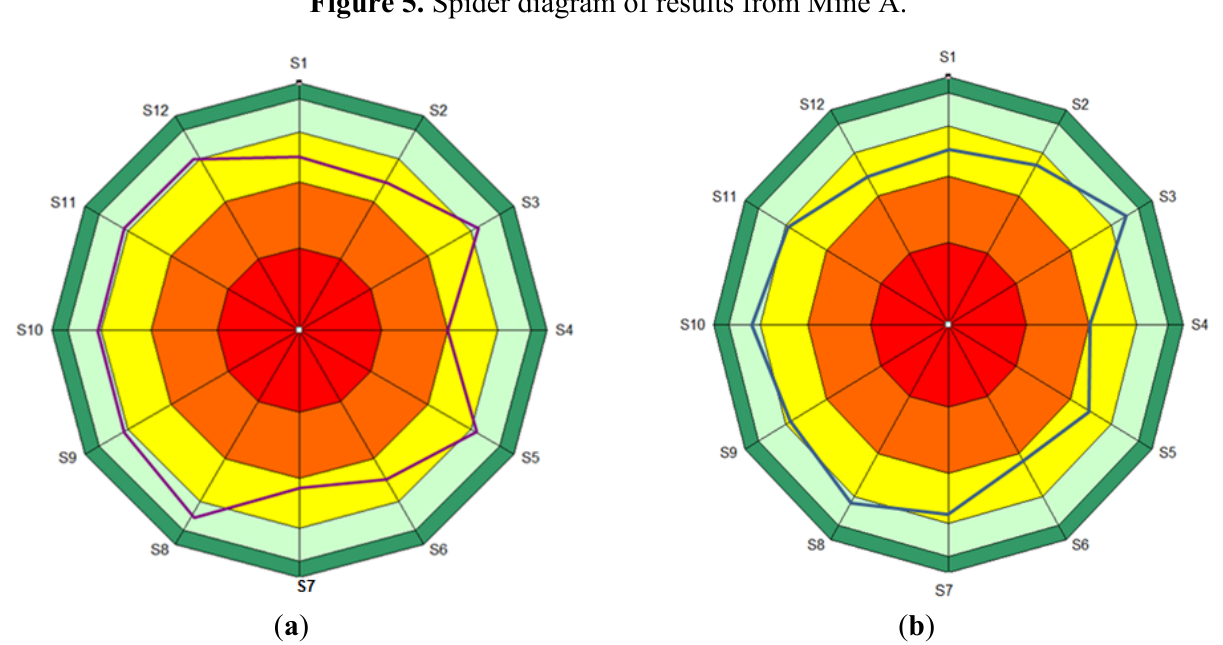
Figure 5. Spider diagram of results from Mine